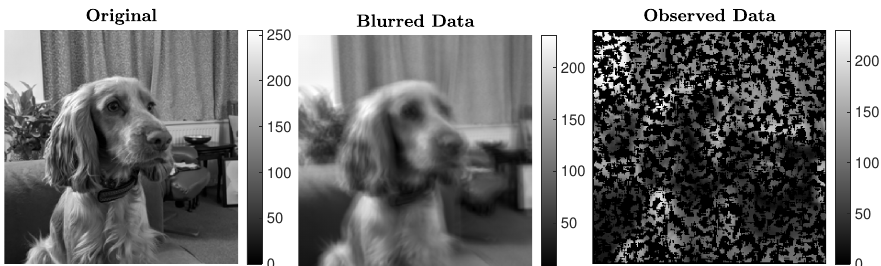
Figure 6. Experiment 2. Test problem involving shaking blur followed by inpainting